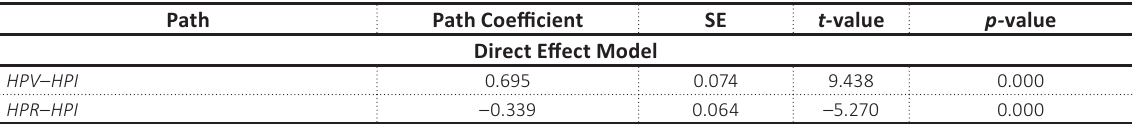
Table 4. Direct effect